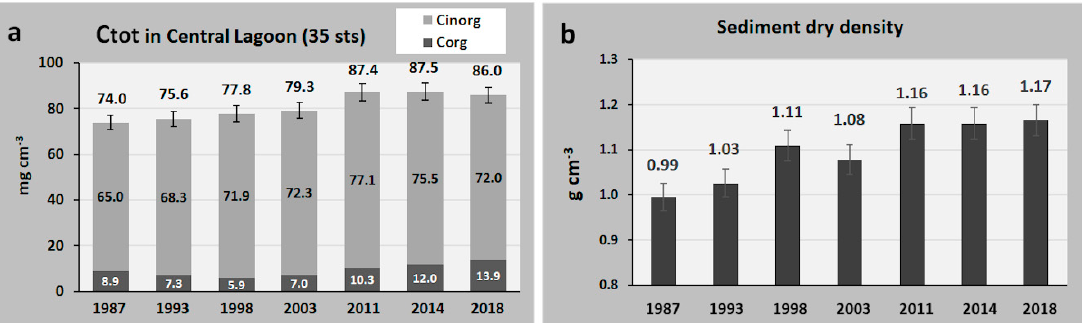
Figure 4. Distribution maps of Ctot and Corg in the surface sediments of the whole Venice Lagoon.